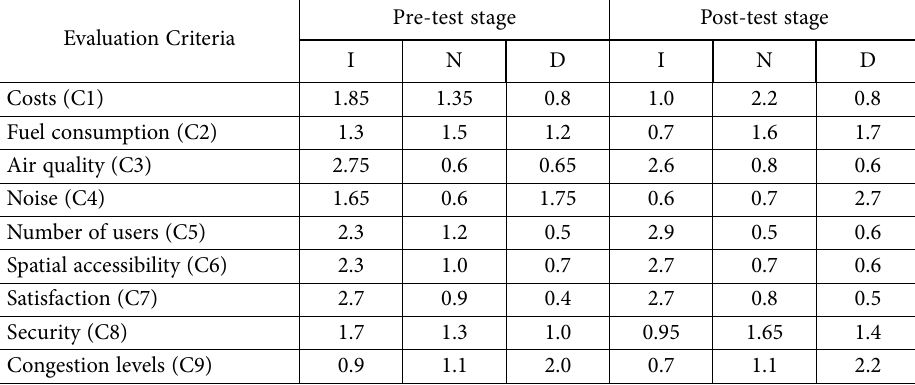
Table 3. Data after information integration Evaluation Criteria